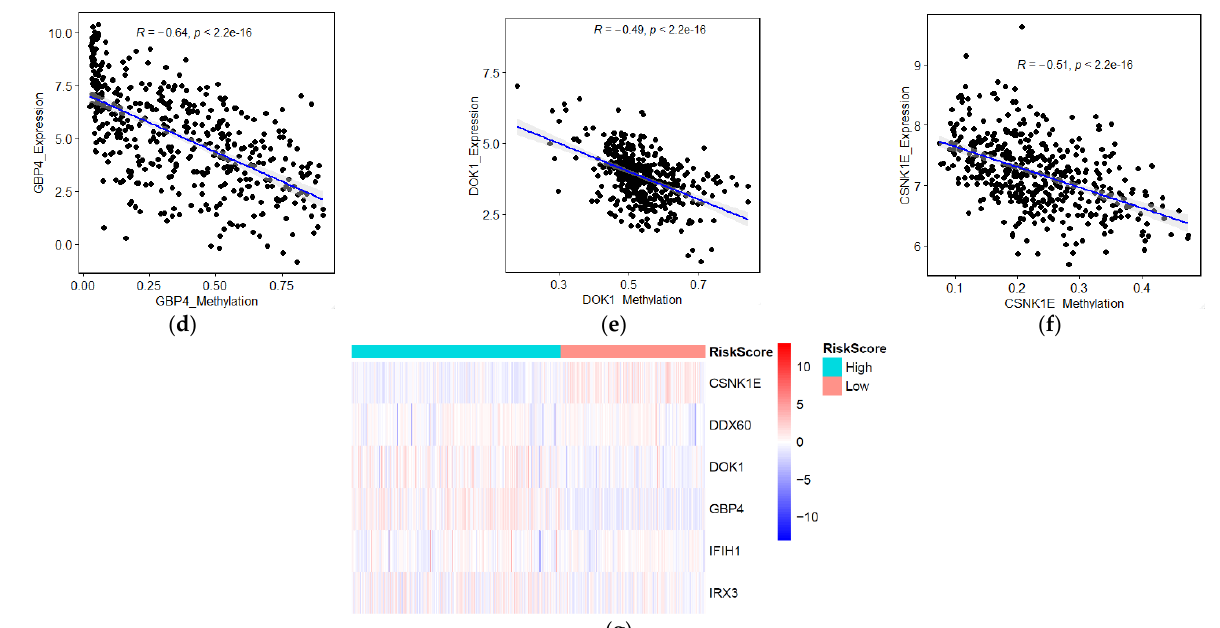
Figure 6. Identification of aberrant mechanisms in high–risk groups. ( a ) Heatmap shows normalized pathway enrichment scores in two high- and low-risk score subtypes. The 36 significantly enriched pathways are plotted (Fold changes >1.5, FDR < 0.01); ( b ) Boxplot of T cell infiltration score; ( c ) Frequency of the 7 prognostic genes in total samples from the TCGA dataset (Data were derived from the cBioPortal database). Correlations between mRNAs levels and methylation levels of GBP4 ( d ), DOK1 ( e ), CSNK1E ( f ); ( g ) Heatmap of methylation levels of candidate biomarker genes.